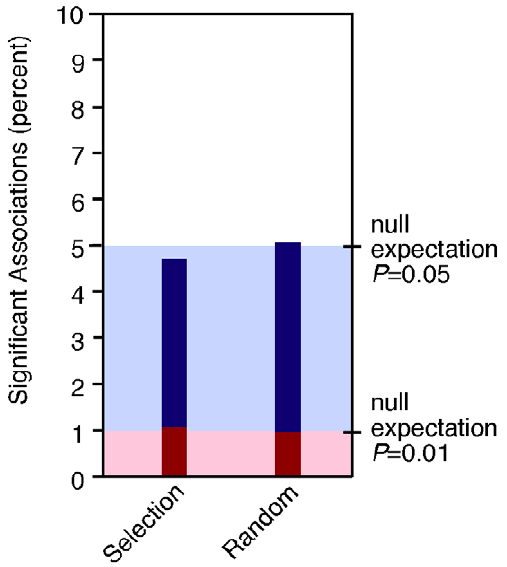
Figure 2. Graph of the percent of association tests observed to be significant. The columns represent the percent of significant association tests ( P , 0.05) observed for each specific group of genes (selection-candidate or random). The light blue shading indicates the expected percent of associations (5.0%) with a P -value of less than 0.05 under the null hypothesis of independence between the SNP and the trait. The red areas of the columns designate the subset of significant associations with a P -value of less than 0.01 for each specific group of genes. The red shading indicates the expected percent of associations (1.0%) with a P -value of less than 0.01 under the null hypothesis of independence between the SNP and the trait. Both the selection- candidates and the random genes had no more significant associations with trait variation in teosinte than would be expected under the null